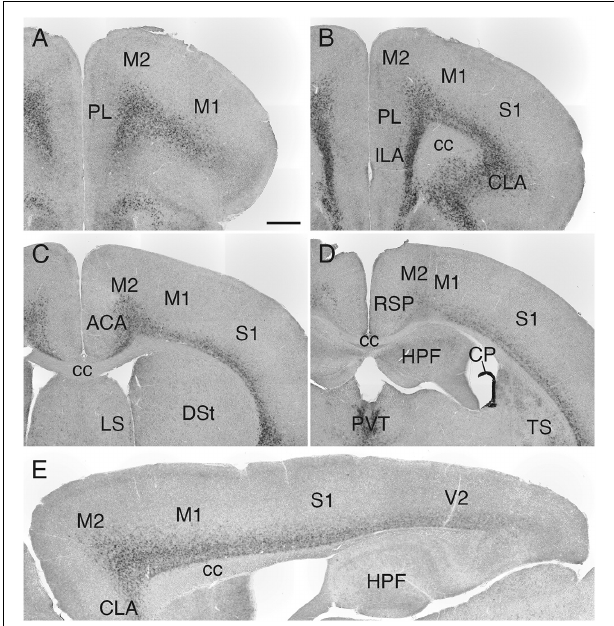
FIGURE 3 | Sulf1 mRNA expression in the cerebral cortex. (A–D) Sulf1 was expressed in layer 6 of the cerebral cortex. Coronal sections from the rostral (A) to the caudal (D) levels are shown. (E) Sagittal section showing the Sulf1 expression in the cerebral cortex throughout the rostrocaudal axis. The expression showed a high-rostral to low-caudal gradient. ACA, anterior cingulate area; cc, corpus callosum; CLA, claustrum; CP, choroid plexus; DSt, dorsal striatum; HPF, hippocampal formation; ILA, infralimbic area; LS, lateral septal nucleus; M1, primary motor area; M2, secondary motor area; PL, prelimbic area; PVT, paraventricular nucleus of the thalamus; RSP, retrosplenial area; S1, primary somatosensory area; TS, posterior tail of the striatum; V2, secondary visual cortex. The scale bars indicate 500 µ m (A–D) and 400 µ m (E) . Approximate AP levels from the bregma (in mm) are 2.5 (A) , 2.0 (B) , 0.5 (C) , and –1.0 (D) . The approximate ML level from the midline (in mm) is 1.0 (E)